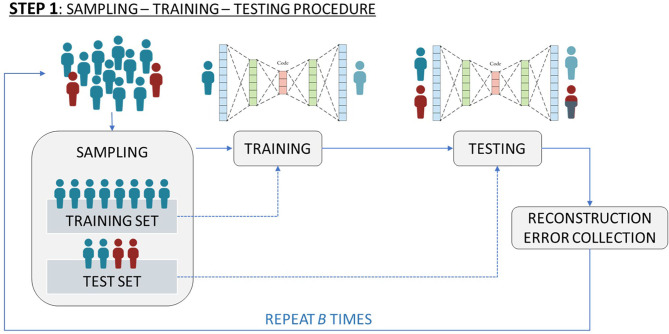
Simplified scheme of a Deep AutoEncoder.